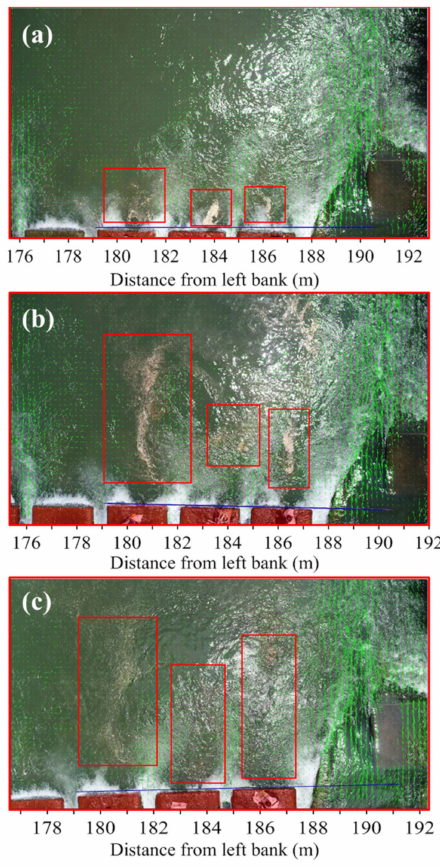
Figure 7. Flow field measurements collected using LSPIV derived from a UAV at a flight height of 12 m with artificially seeded particles of ( a ) 1.5 kg/min, ( b ) 3 kg/min, and ( c ) 4.5 kg/min. The blue line in the figure represents the x -axis direction. Note that the red square indicates the artificial particles (i.e., wood